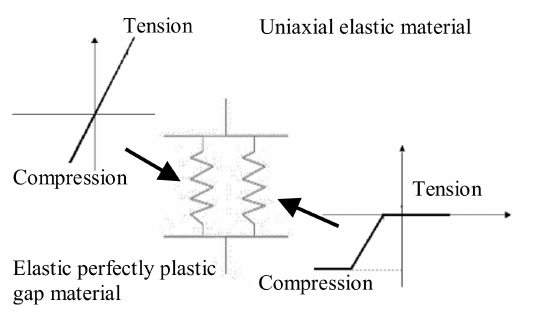
Figure 4. A two-node parallel spring element used for hold-downs